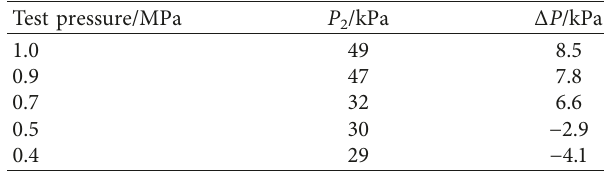
Table 3: Model calculation results.